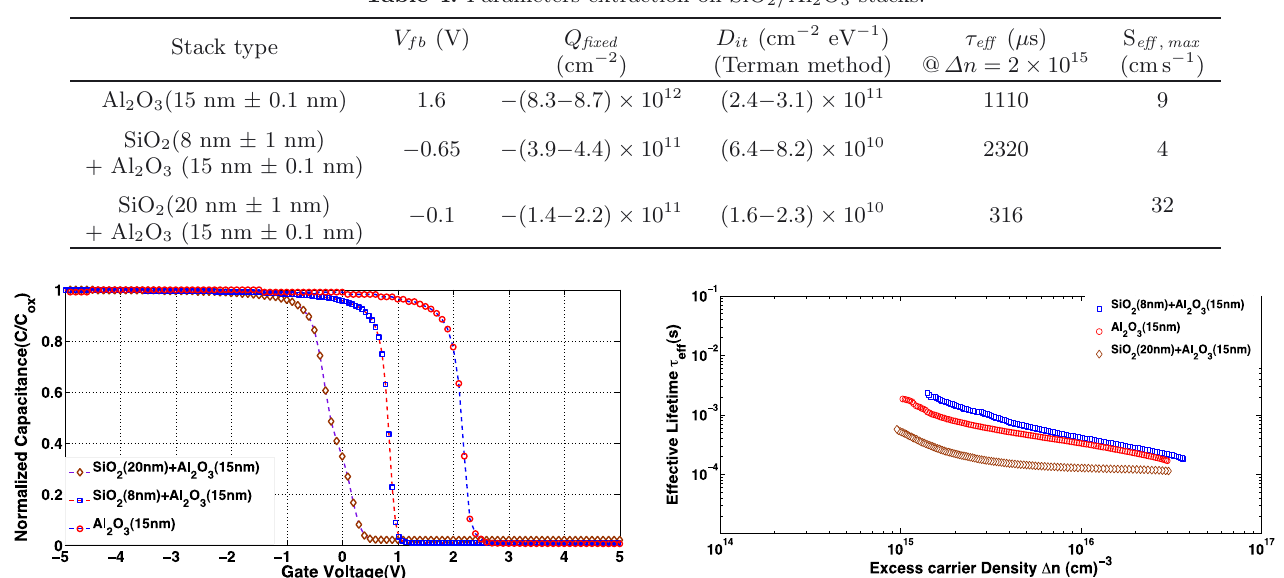
Table 4. Parameters extraction on SiO 2 /Al 2 O 3 stacks.